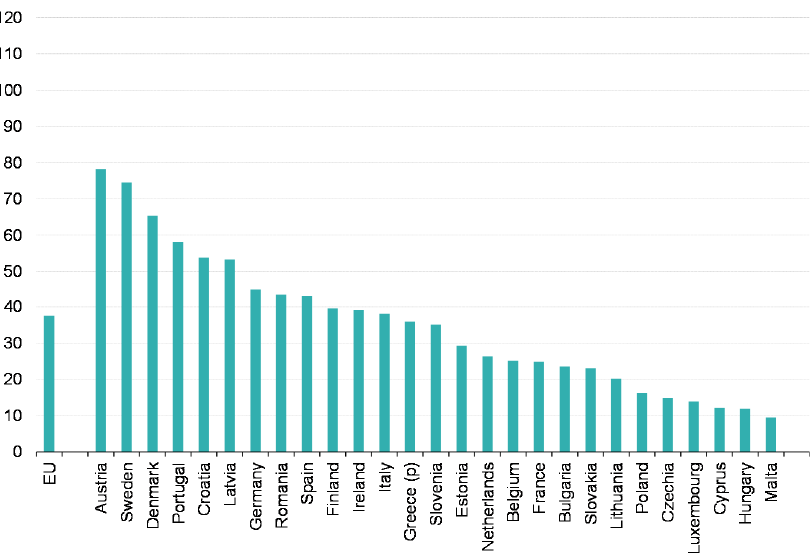
Figure 2. Share of Energy from Renewable Sources in the EU in Gross Electricity Consumption. Source: Eurostat (online data code: nrg_ind_ren).